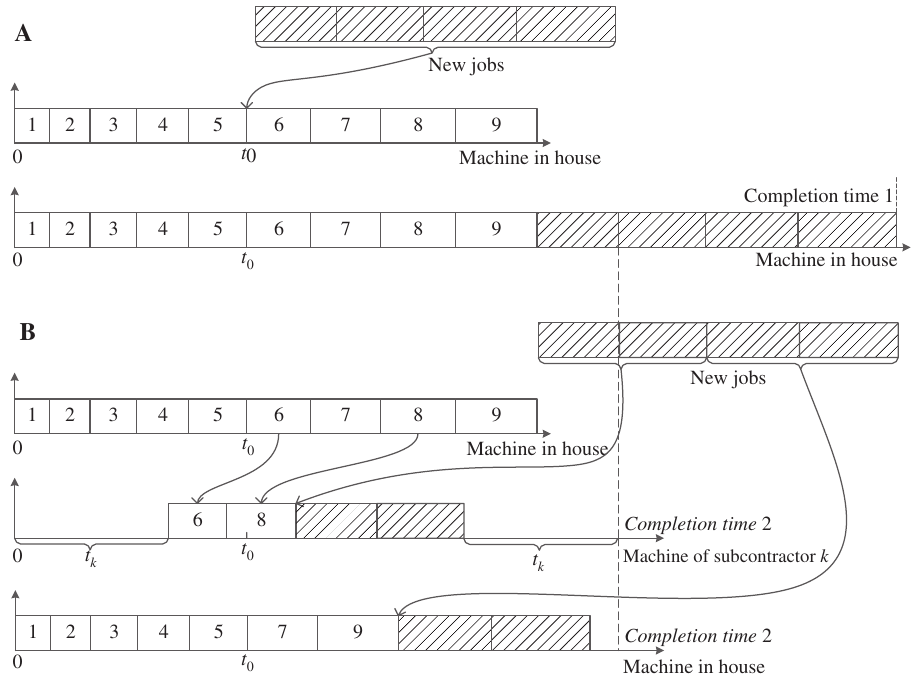
Figure 1: (A) Usual Practice of Disruption of New Job Arrivals. (B) Outsourcing for New Job Arrivals in